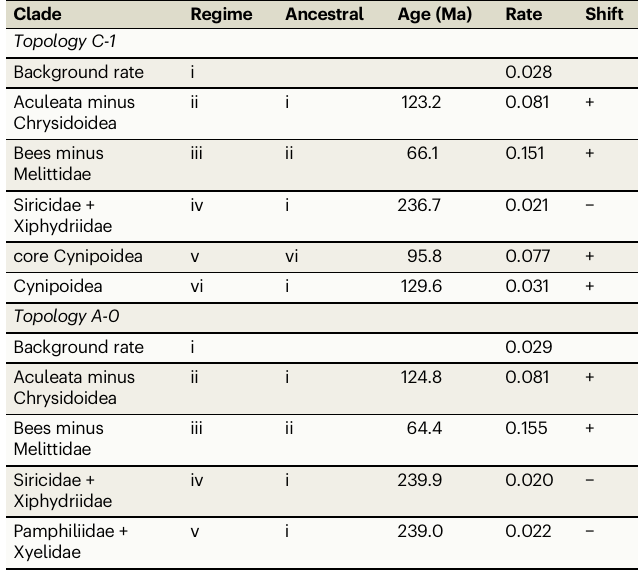
Table3|Summaryofdiversi fi cationratesand shiftsestimated with MEDUSA